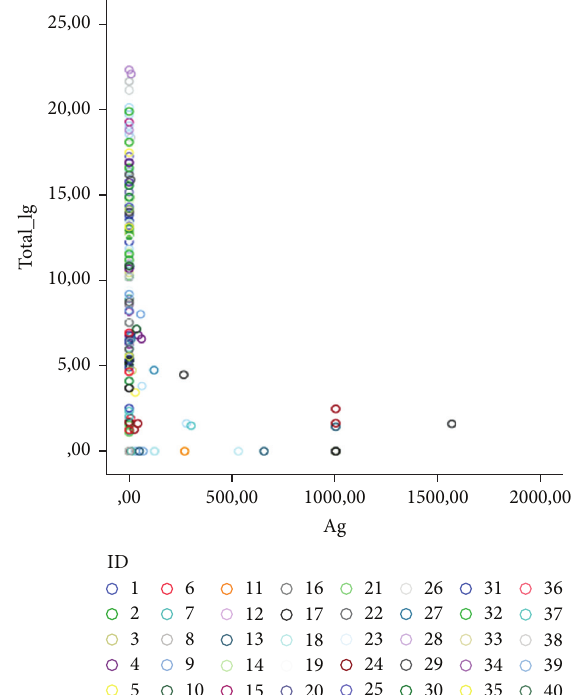
Figure 1: Scatter plot of all Ag-total Ig values. Markers have been set by case ( ρ � − 0.327/ p < 0.001), and lymphocyte (LYMP) levels ( ρ � − 0.216/ p � 0.004). Total Ig levels positively correlated with ALT ( ρ 0.288/ p < 0.001), LDH ( ρ � 0.207/ p � 0.005), ferritin ( ρ � 0.199/ p � 0.008), WBC, neutrophils (NEU), PLT, and LYMP levels ( ρ � 0.257/ p � 0.001, ρ � 0.259/ p < 0.001,